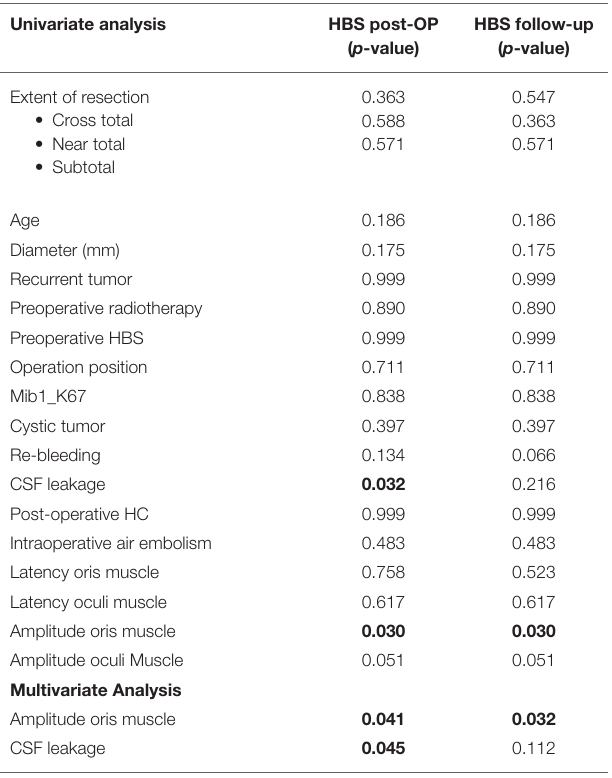
TABLE 3 | Univariate and multivariate analyses for HBS post-op and HBS in the follow-up concerning preoperative, perioperative, and postoperative variables. Univariate analysis HBS post-OP